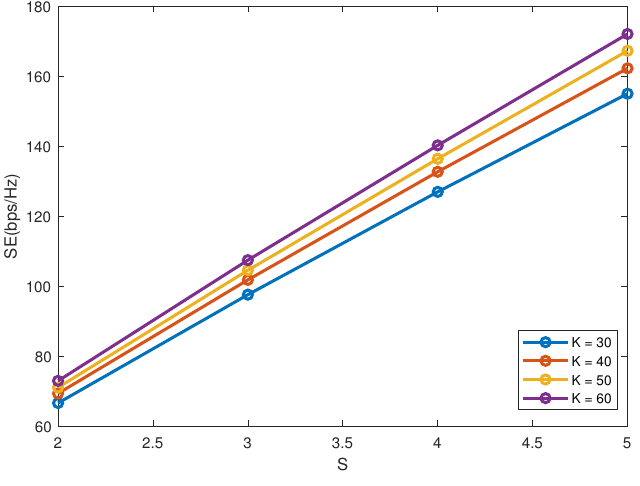
Figure 5. SE versus S .